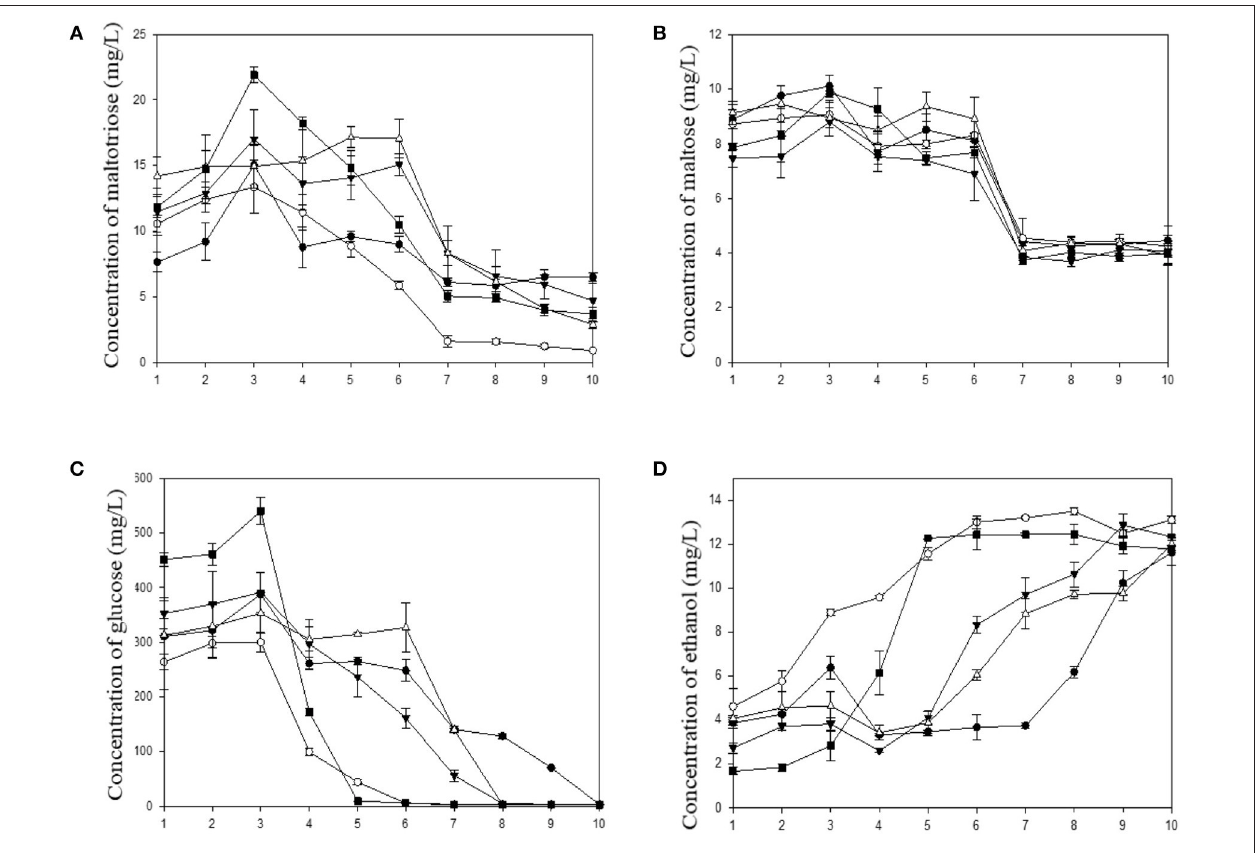
FIGURE 5 | Kinetic of carbohydrate consumption and ethanol production during fermentation based on five microbial starters. (A) Maltotriose, (B) Maltose, (C) Glucose, and (D) Ethanol concentration. (DBB, • DCK, ◦ DOB, N DOS, and (cid:4)